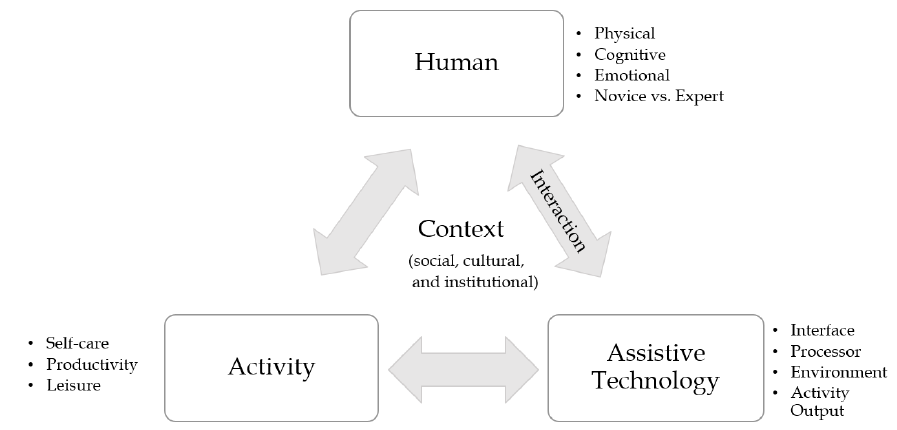
Figure 1. The four components of the Human Activity Assistive Technology (HAAT) model presented in [4]. The interaction between the human and the assistive technology (AT) is emphasized to highlight the relationship between the needs of the AAC users and the elements of development of high-tech solutions discussed in this